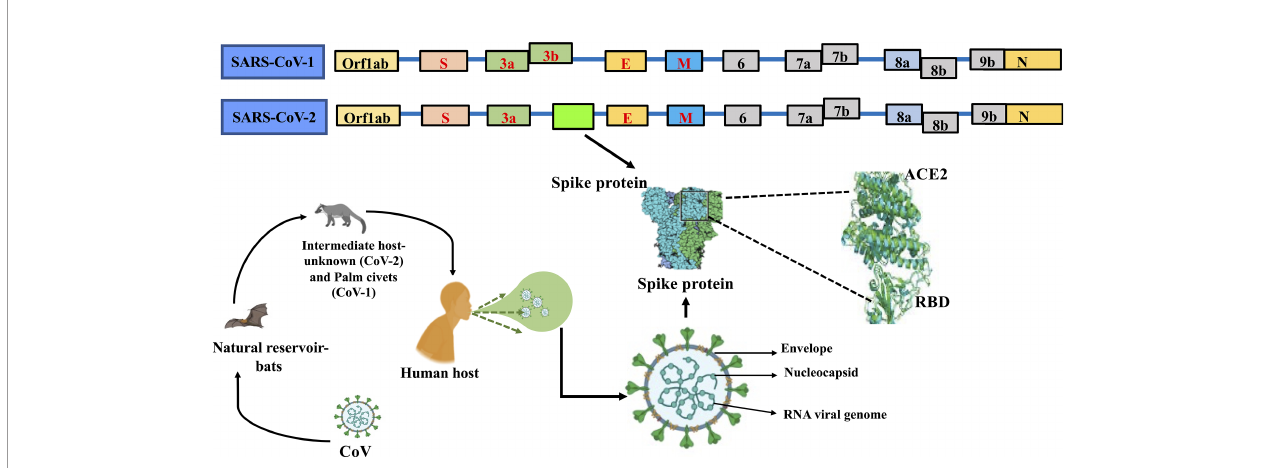
FIGURE 1 | Genome comparison of SARS-CoV and SARS-CoV-2 along with ORFs depicting the common